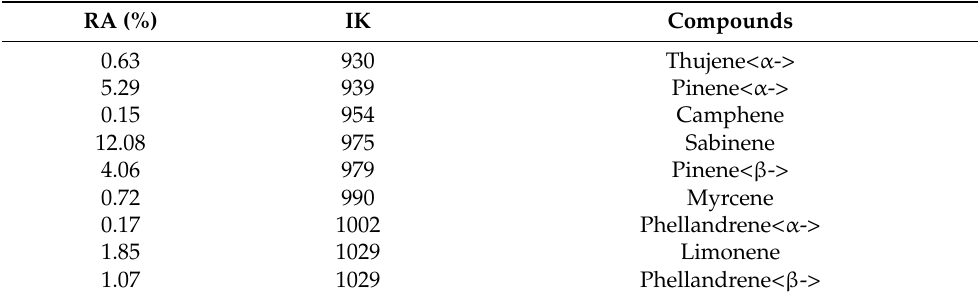
Table 5. The chemical composition of EO of Laurus nobilis